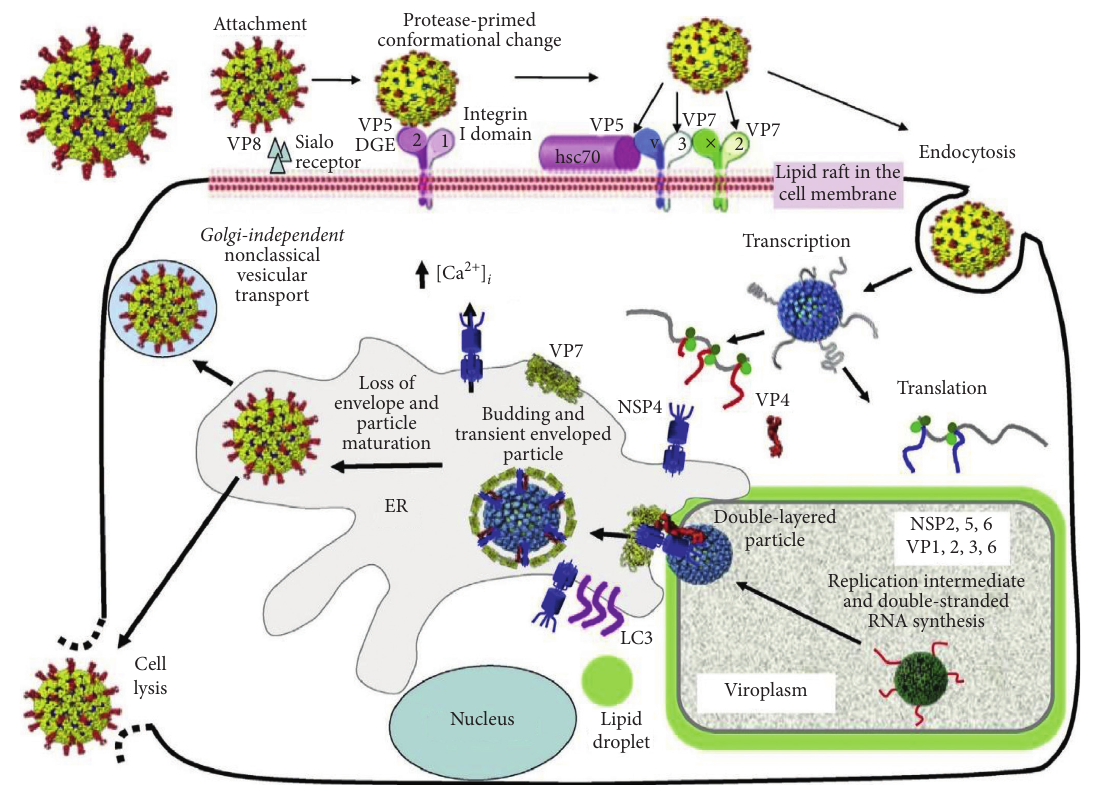
Figure 2: The rotavirus replication cycle. Source: